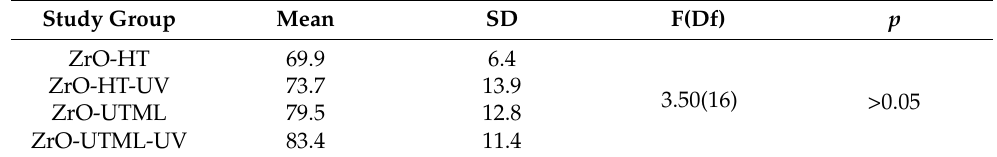
Table 3. Water contact angle in degrees for the four groups is presented as means ± standard deviations. Study